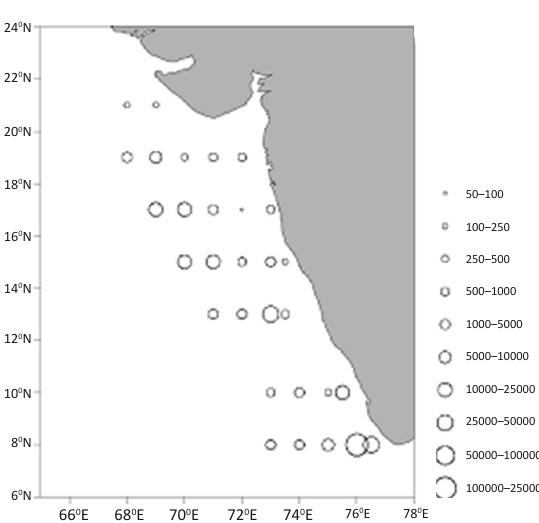
Figure 3. Spatial distribution of planktonic ostracod abundance in the mixed layer of the Arabian Sea during the Summer